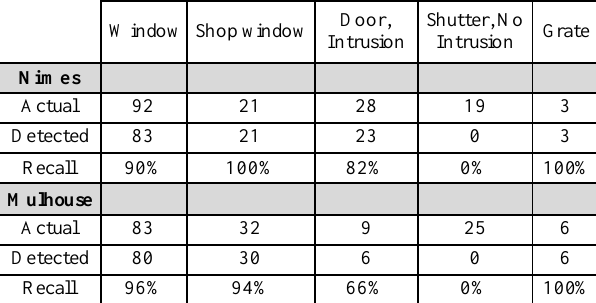
Table 2: Object-based detection results for 5 classes of openings Pixel-based evaluation. The results are now evaluated pixel-by -pixel using ground truth on the wall textures. Indeed, sampling